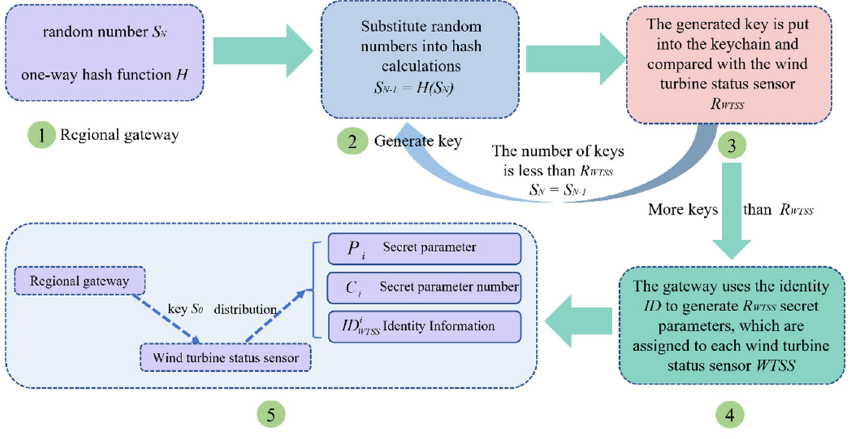
Figure 3. Lightweight key generation process.